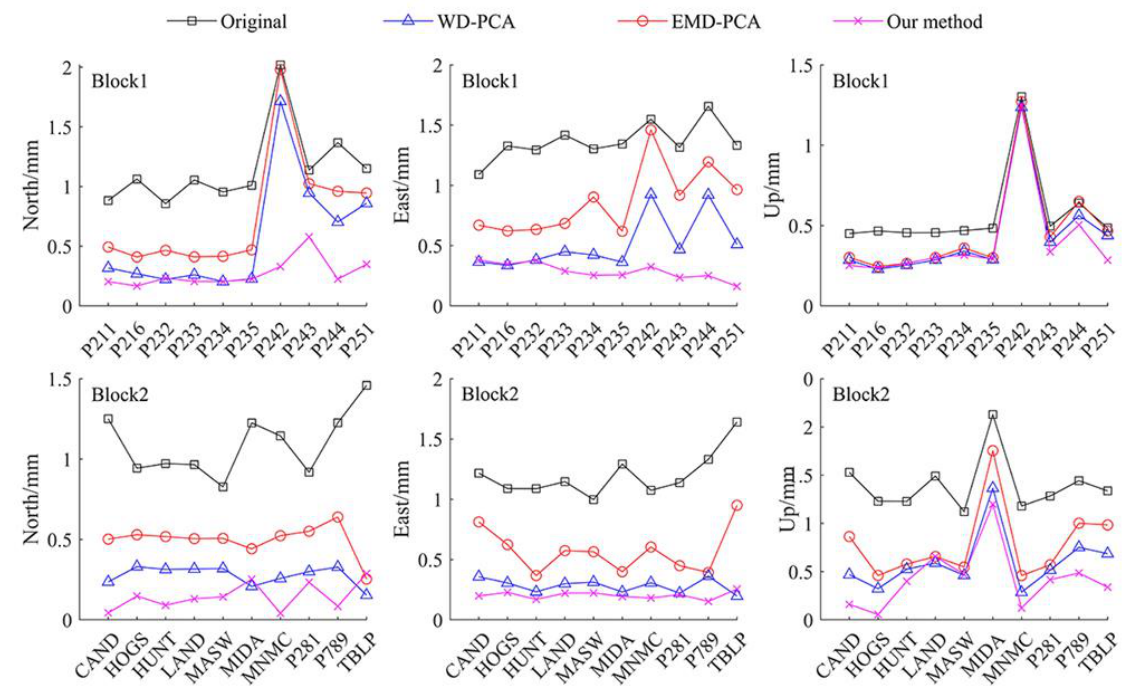
Figure 7. Standard deviations of raw and denoised GNSS residual data in three directions for Blocks 1 and 2.